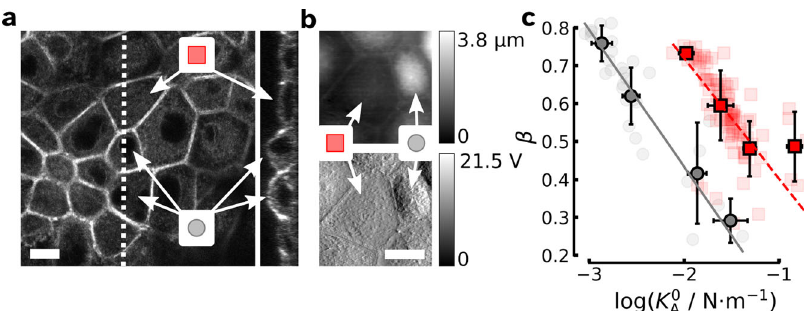
Fig. 5 Internal cell stress generated by adjacent ZO1/2 dKD MDCK II cells. a Confocal laser scanning image (CLSM, F-actin stained) of typical cells chosen for indentation-relaxation experiments. A corresponding yz -slice of the image stack at the indicated position (dashed white line) is shown on the right. Small cells are marked with a gray circle, while large cells are represented by a red square. Scale bar is 10 μ m. b AFM contact mode topography images of stretched and highly contractile cells. Measured height on top and the error signal is below. Scale bar is 10 μ m. c Small (gray) and large (red) ZO1/2-depleted MDCK II cells subject to indentation-relaxation display distinctly different β ð log ð K 0 ÞÞ trends. Mechanical data is taken from Skamrahl A et al. 29 . While smaller, contractile cells are extremely soft (gray circles, continuous line, n = 30 cells), the larger and outstretched MDCK II cells (red squares, dashed line, n = 93 cells) are almost an order of magnitude stiffer.